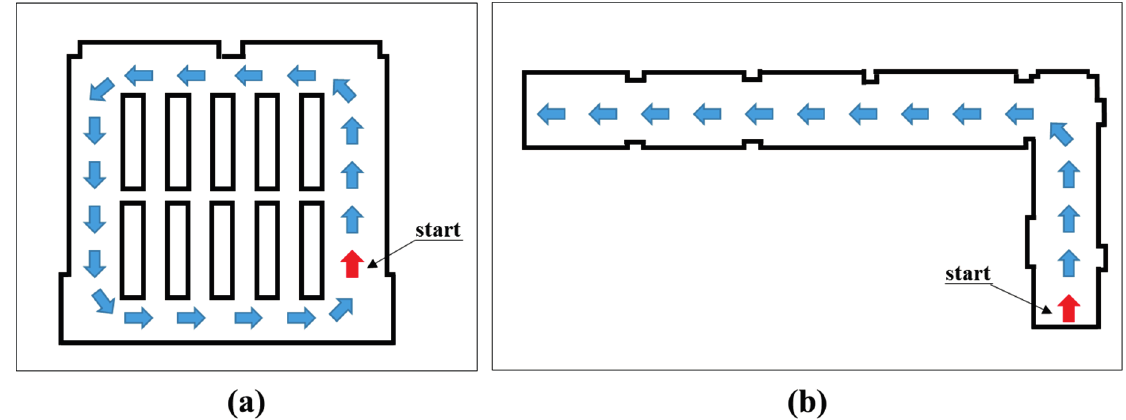
Figure 8. Trajectories of kinematic laser scanning: ( a ) the seminar room; ( b ) the